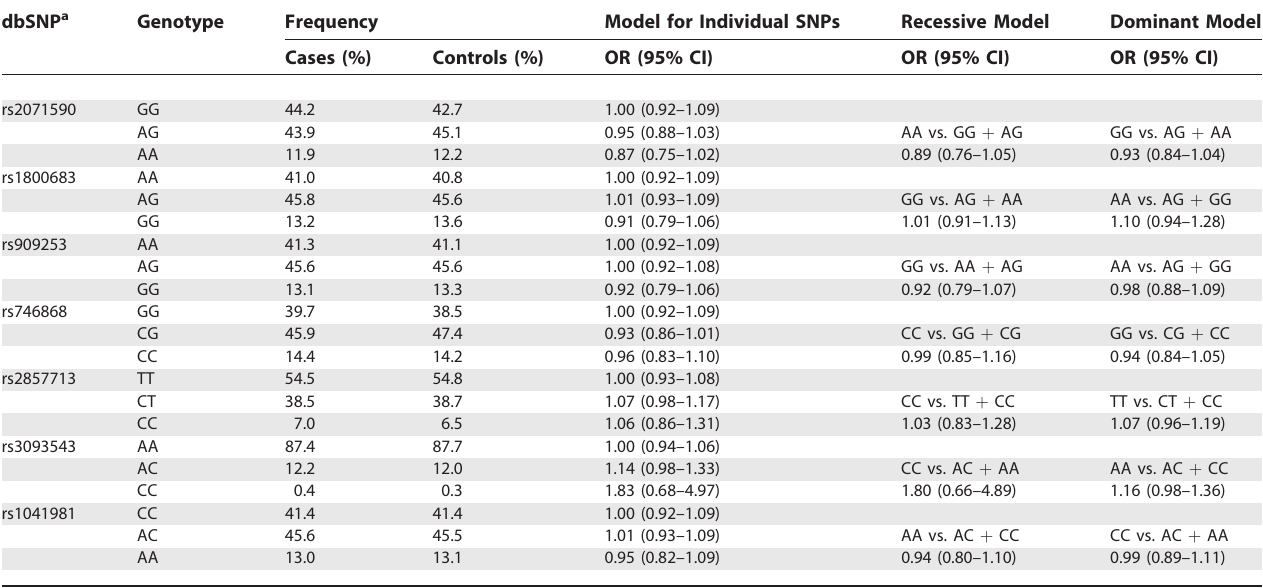
Table 5. Odds Ratio (95% CI) of MI Associated with SNPs for LTA in ISIS Study (Adjusted for Age and Sex)